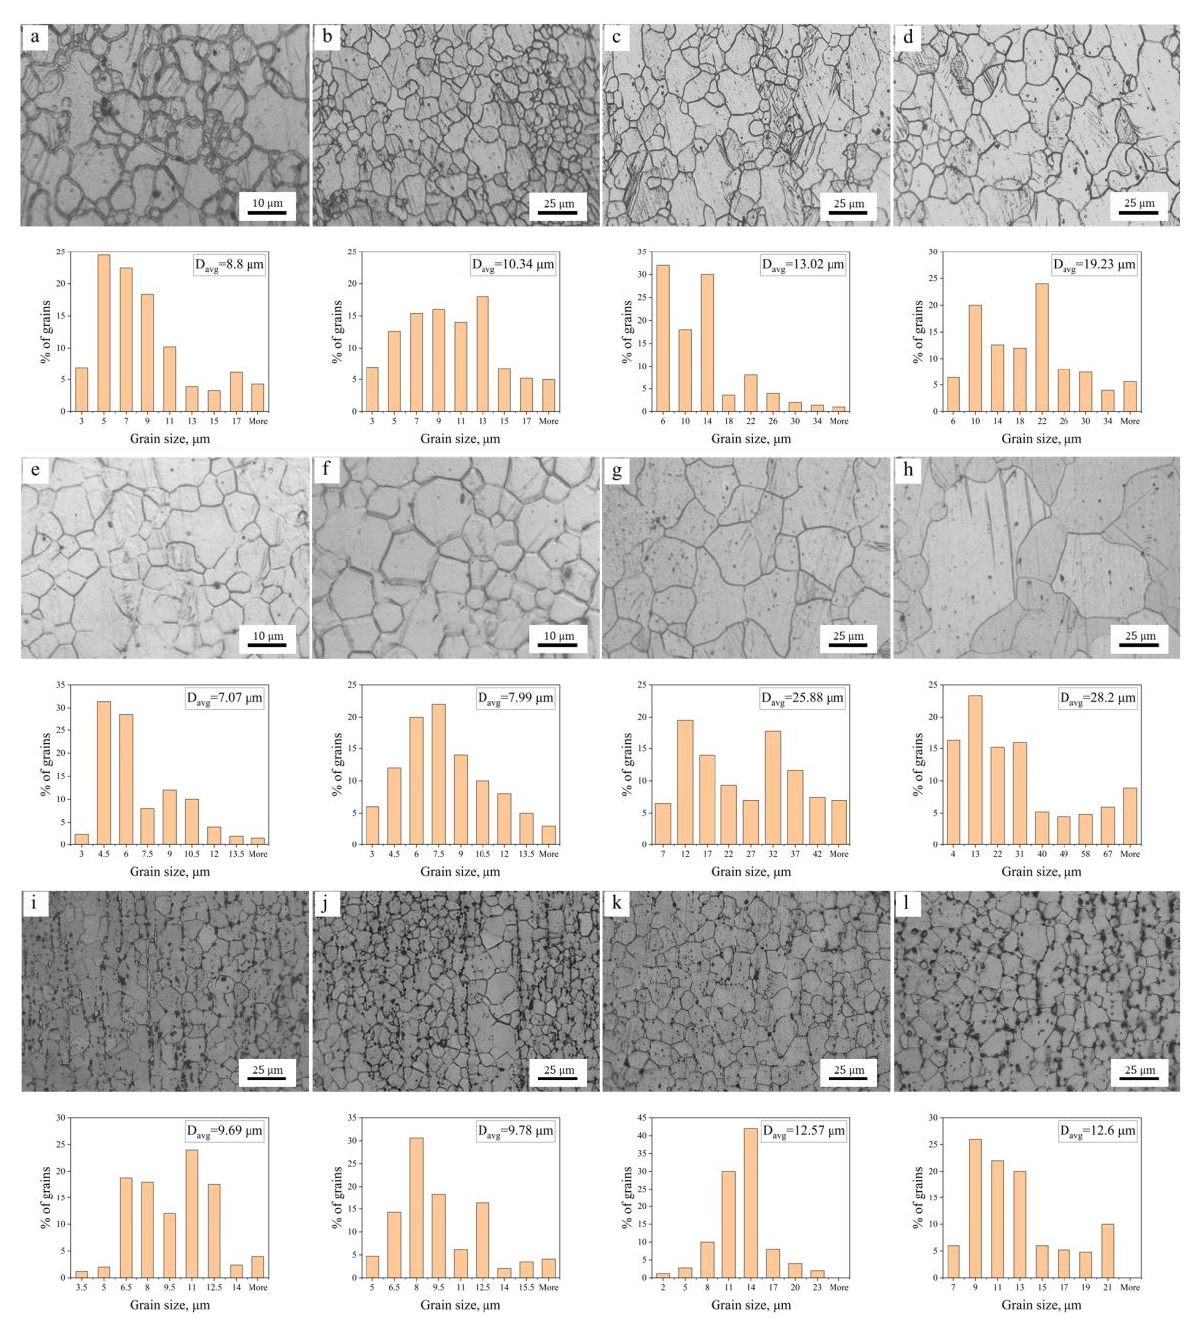
Figure 4. Optical micrographs of ( a – d ) AZ31, ( e – h ) AZ61, ( i – l ) AZ91 annealed at 350 °C for 12, 24, 48, and 72 h. The corresponding histograms of the particle size distribution are shown below each micrograph.